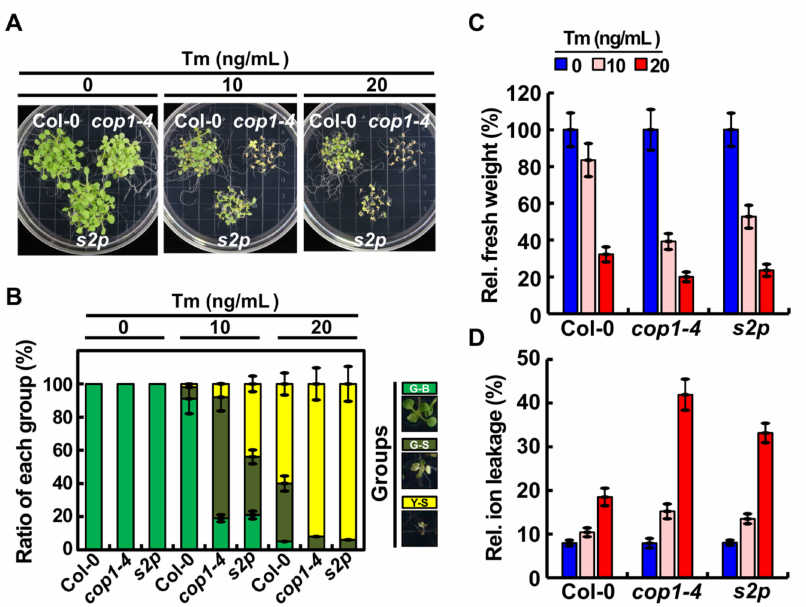
Figure 1. The cop1-4 mutant was sensitive to ER stress. ( A ) Phenotypes of 2-week-old WT (Col-0), cop1-4 , and s2p seedlings grown on MS medium containing 0, 10, or 20 ng/mL tunicamycin (Tm). ( B ) Percentage of Tm-treated plants of each genotype in each of the three classes, green-big (G-B), green-small (G-S), and yellow-small (Y-S) plants, depending on their sensitivity to Tm. Data represent mean ± standard deviation (SD; n = 3). ( C , D ) Relative fresh weight ( C ) and electrolyte leakage ( D ) of plants treated with Tm, as indicated in ( A ). Data represent mean ± SD ( n =